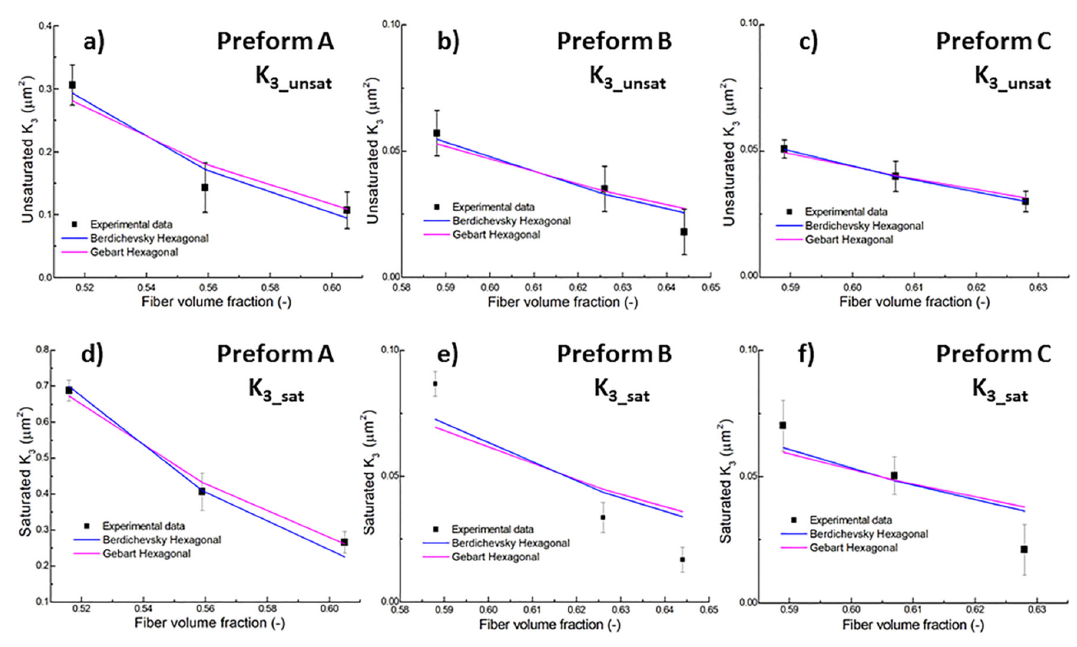
Figure 8. Mathematical modeling of unsaturated ( a – c ) and saturated permeability ( d – f ) values: ( a , d ) preform A; ( b , e ) preform B; ( c , f ) preform C. Table 4. Unsaturated out-of-plane fiber radius obtained from the mathematical modeling of the experimental K 3 values and percentage difference from the nominal fiber radius.